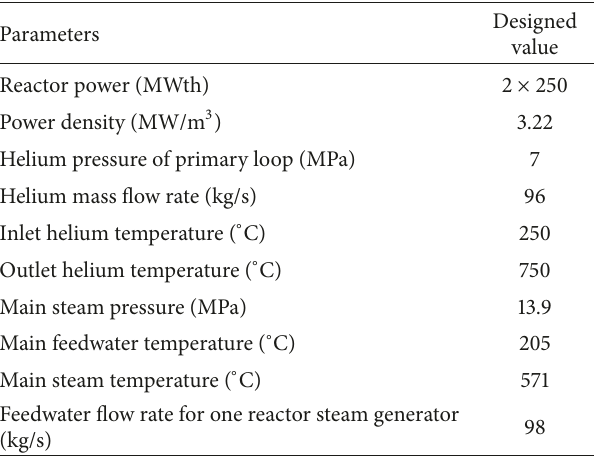
Table 1: Design parameters of HTR-PM.